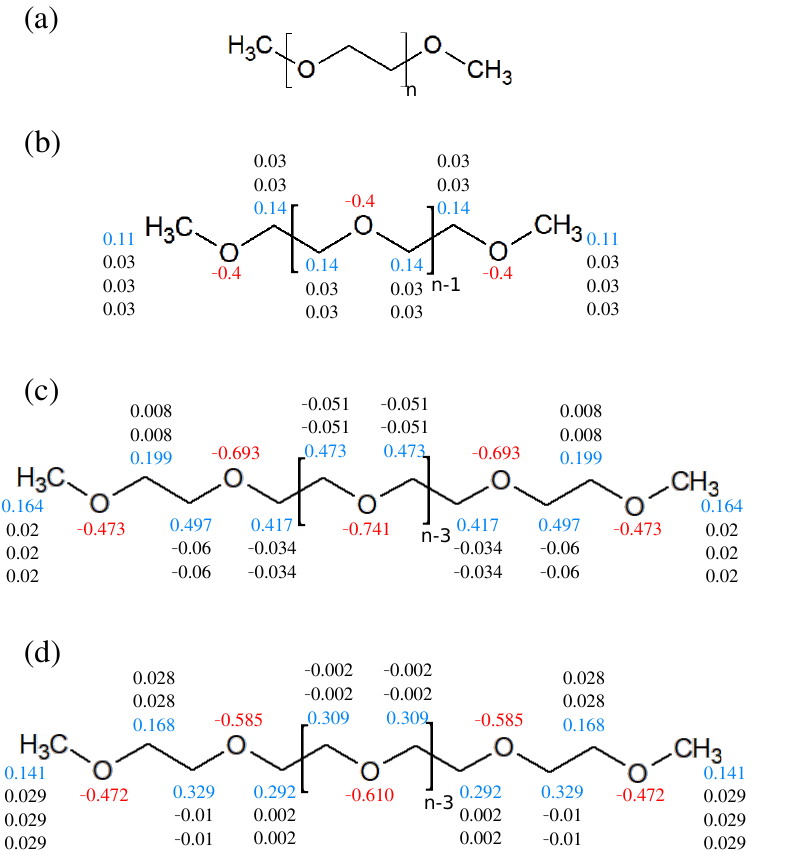
Figure 1. ( a ) The PEO dimethyl ether molecule as representative PEO used in this work, where n (degree of polymerization) was 10 or 20. The atomic partial charges (unit: e-) for PEO with ( b ) default OPLS, ( c ) Barbosa model, and ( d ) reparametrized OPLS R models. The blue and black numbers denote the partial charges for carbon and hydrogen atoms, respectively, in the CH 2 or CH 3